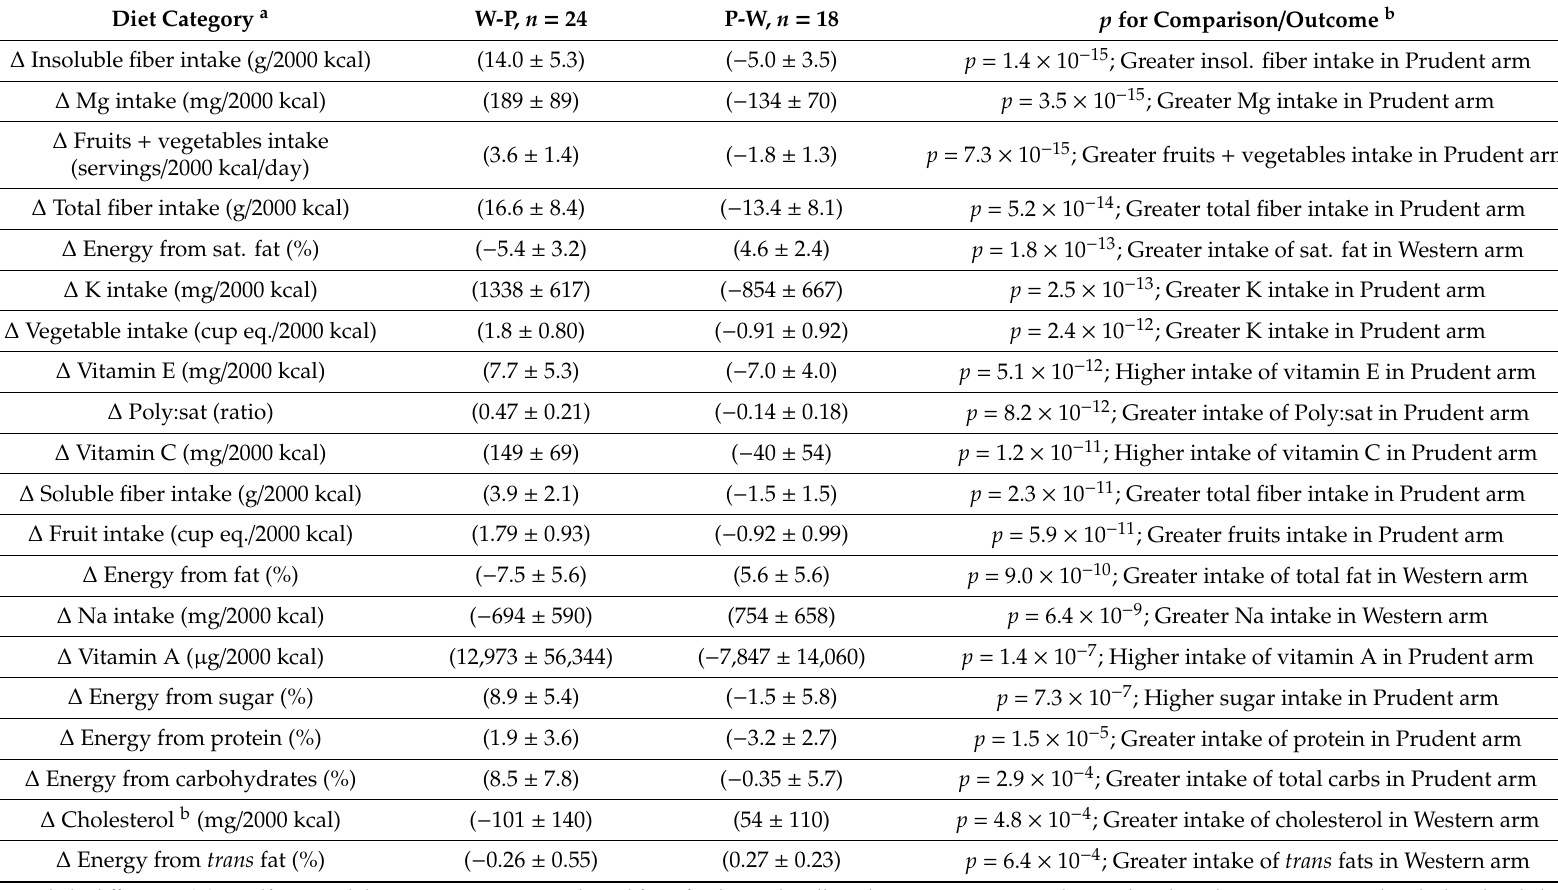
Table 1. Major changes in dietary patterns following two weeks of a Prudent or Western diet relative to baseline habitual diet of DIGEST participants ( n = 42) based on self-reported diet